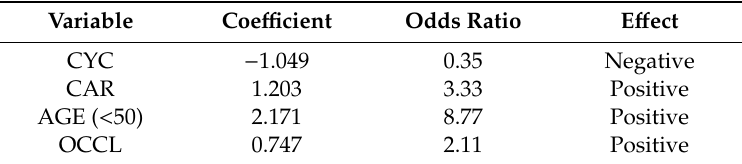
Table 3. E ff ects of the estimated coe ffi cients on the probability p ( x